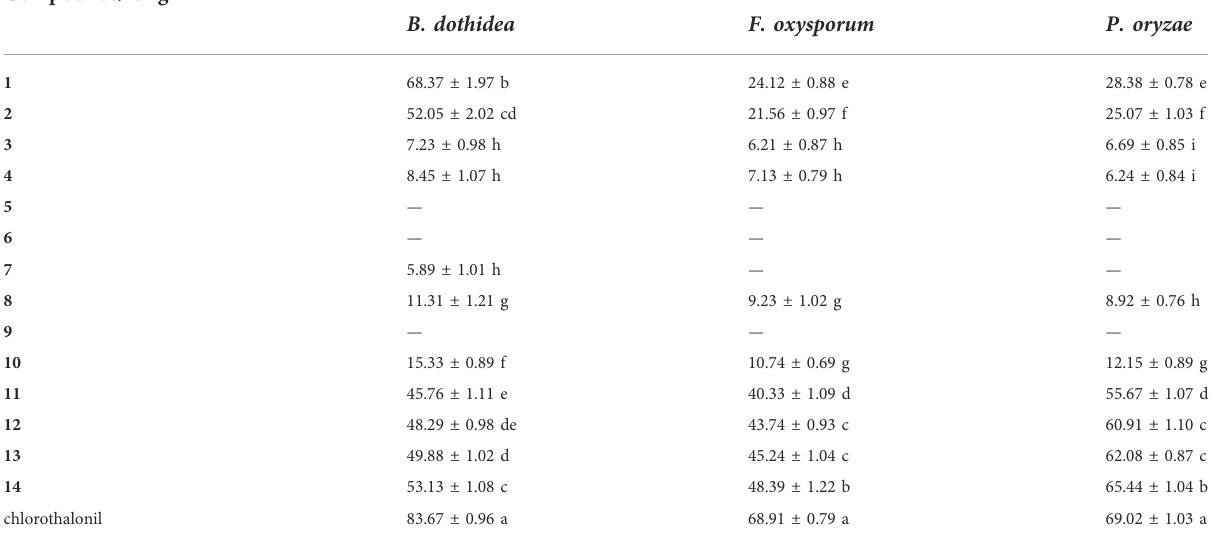
TABLE 2 The antifungal activities of compound 1 – 14 against three fungi (100 μ g/mL).